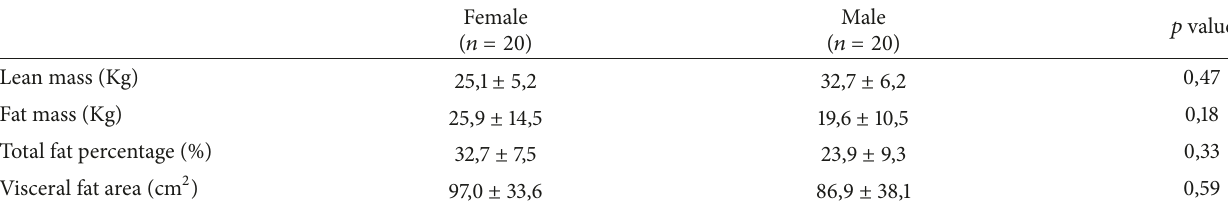
Table 4: People living with HIV/AIDS body composition separated by gender.